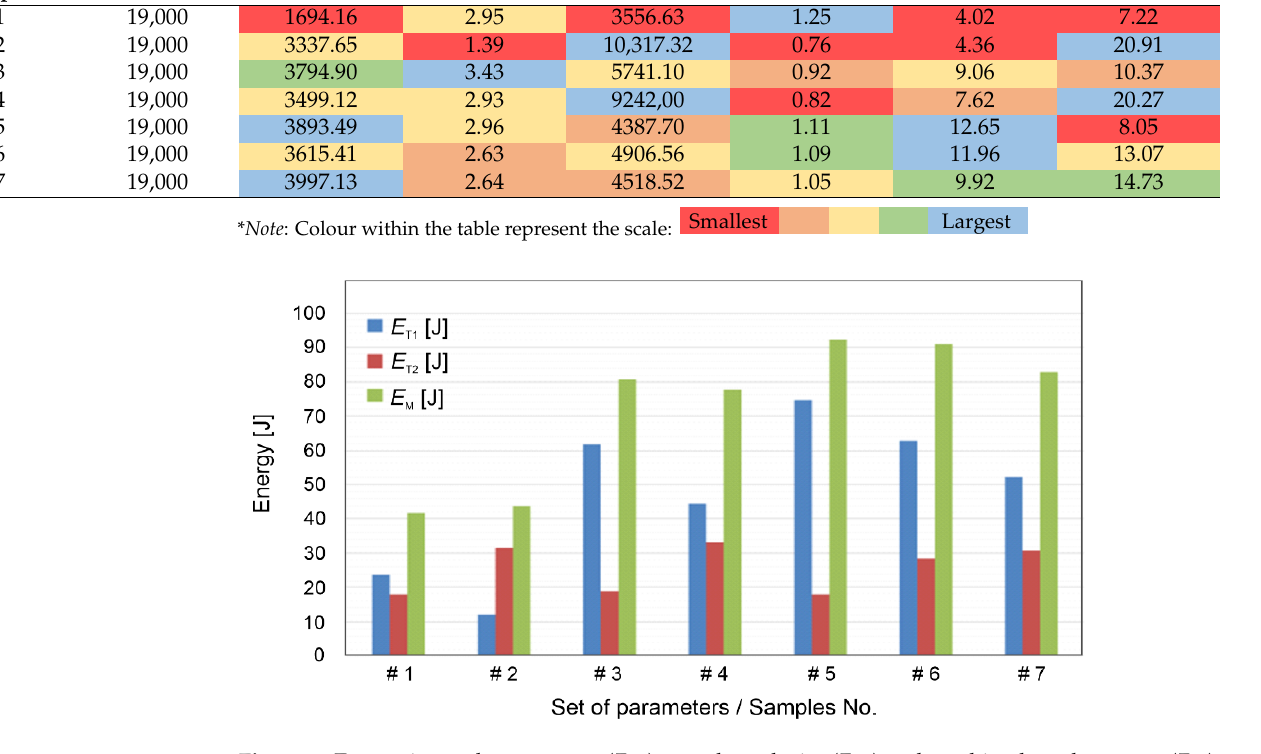
Figure 5. Energy input due to torque ( E T1 ), angular velocity ( E T2 ) and combined mech. energy ( E M ).